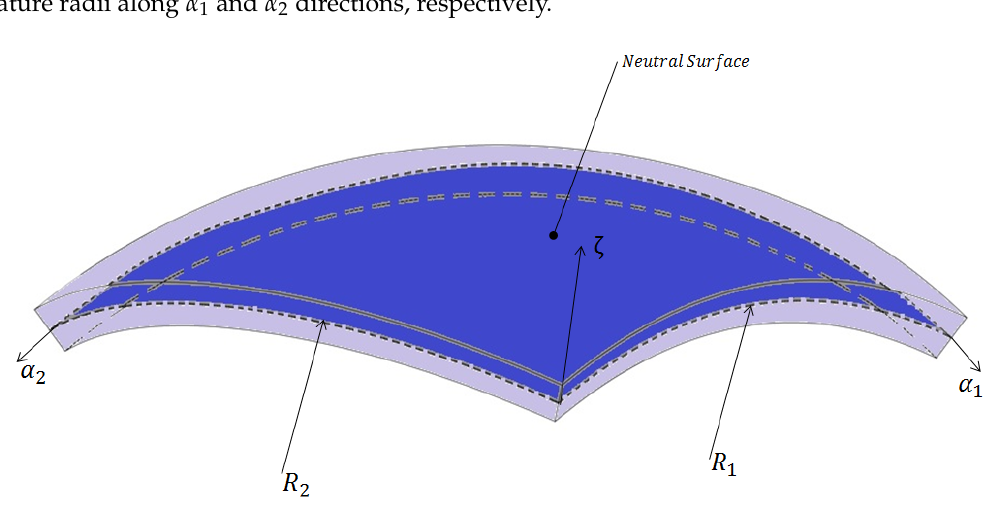
Figure 1 . Geometry of doubly ‐ curved shell and its coordinate systems. Figure 1. Geometry of doubly-curved shell and its coordinate